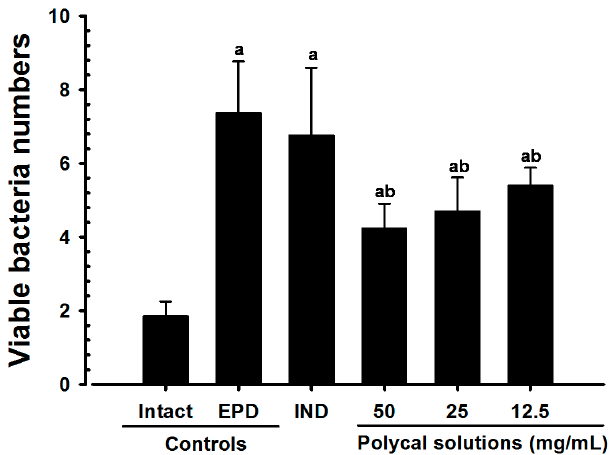
Figure 2. Alveolar Bone Loss Scores in Intact or EPD Rats. Note that significant increases of exposed teeth roots areas and the alveolar bone loss scores were detected in EPD control as compared with Intact control. However, significant decreases of alveolar bone loss scores were detected in IND 5 mg/kg orally administrated rats and also in all three different concentrations of Polycal topically applied rats as compared with EPD control, respectively. Especially, all three different concentrations of Polycal topical applied rats showed decreases of bone loss scores as compared with EPD control rats. Values are expressed mean ± S.D. of eight rats, mm. EPD = experimental periodontal diseases induced by ligature placement around the cervix of upper left incisor teeth; Polycal = Polycan and calcium gluconate 2:98 (g/g) mixture, which was topically applied to ligated gingival regions, once a day for 10 days (200 μ L/rats); IND = Indomethacin, which was orally administered at 5 mg/kg dose level, once a day for 10 days. a p < 0.01 as compared with Intact control; b p < 0.01 as compared with EPD control.